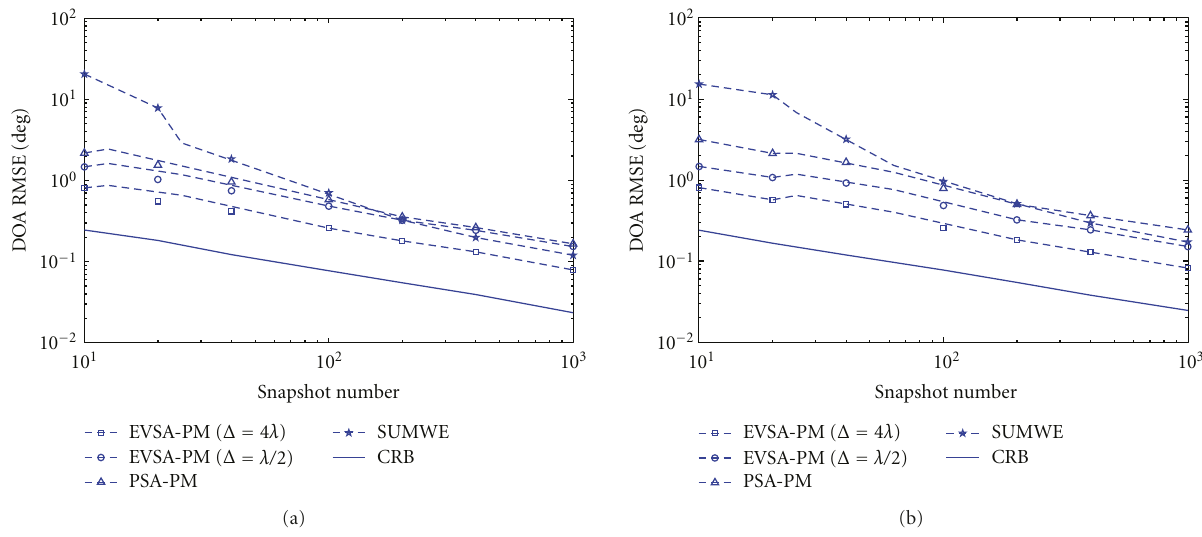
Figure 4: DOA estimate RMSEs of EVSA-PM, PSA-PM and SUMWE against the number of snapshots. (a) Source 1, (b) source 2.